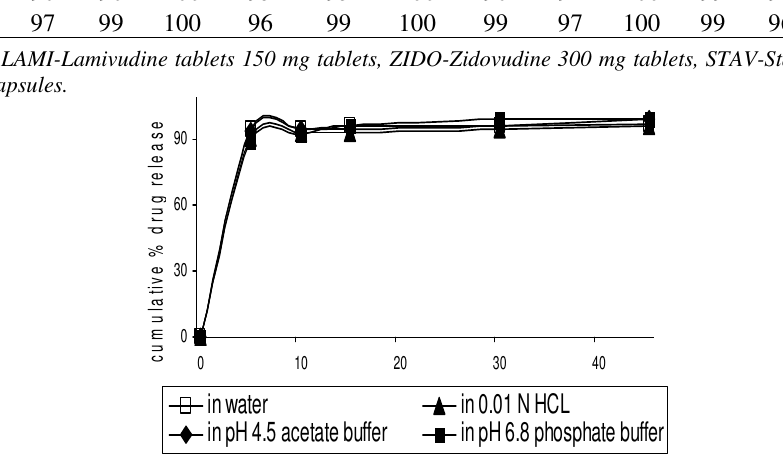
Figure 2. Drug release rate of Lamivudine tablets 150 mg in various pH media